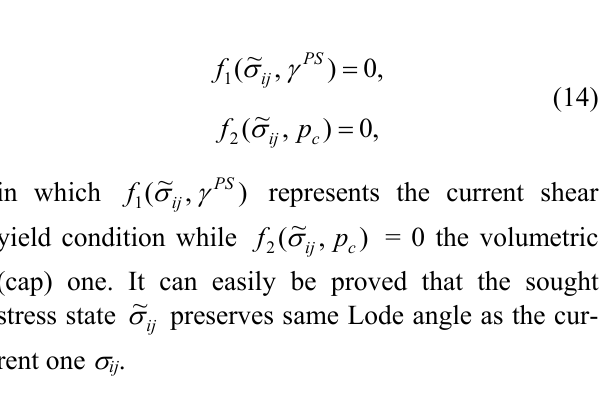
Fig. 2. Graphical representation of p cs